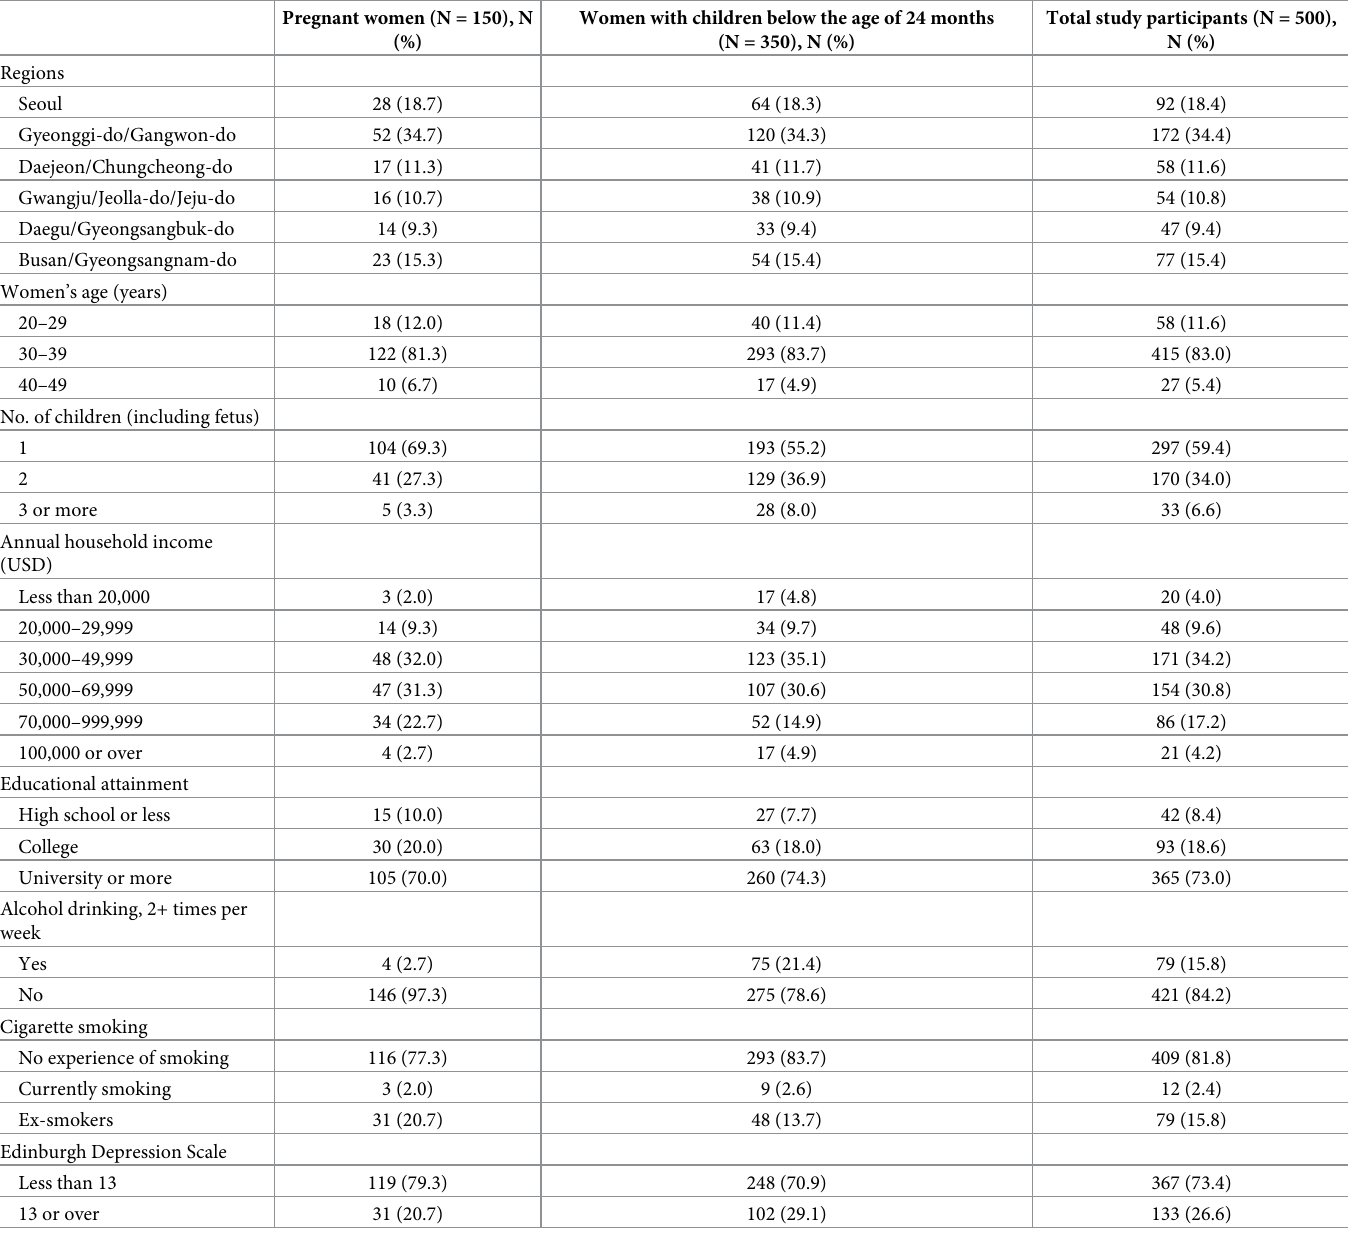
Table 1. Characteristics of study participants according to pregnancy status (N =